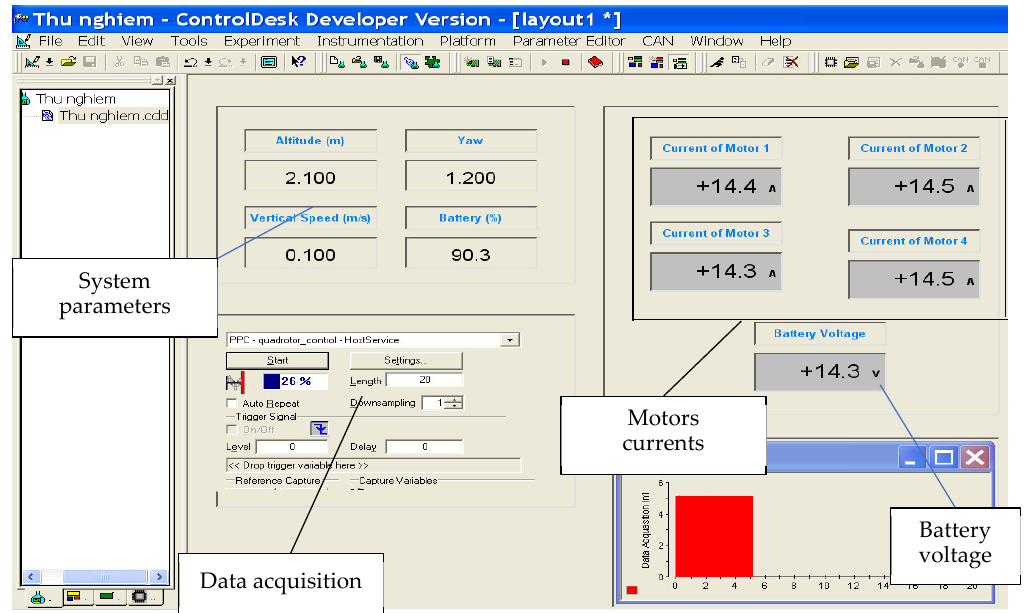
Figure 21. dSPACE’s interface.